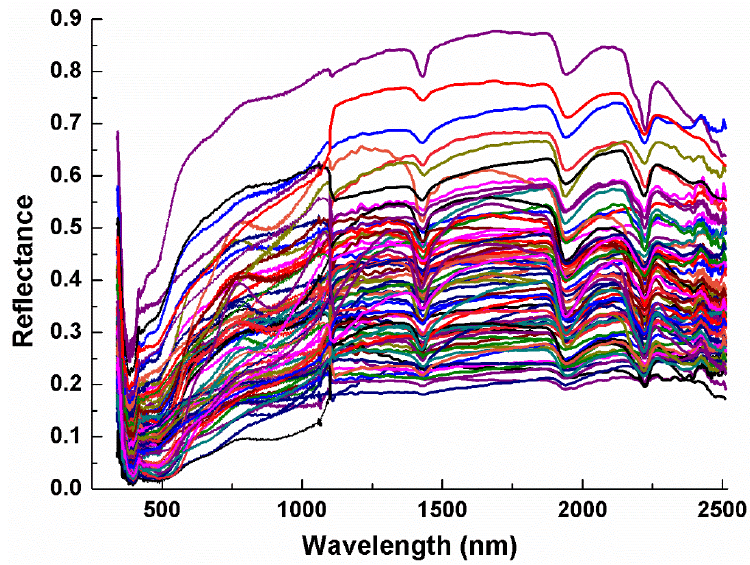
Figure 3. Spectrum curves of 75 soil samples.